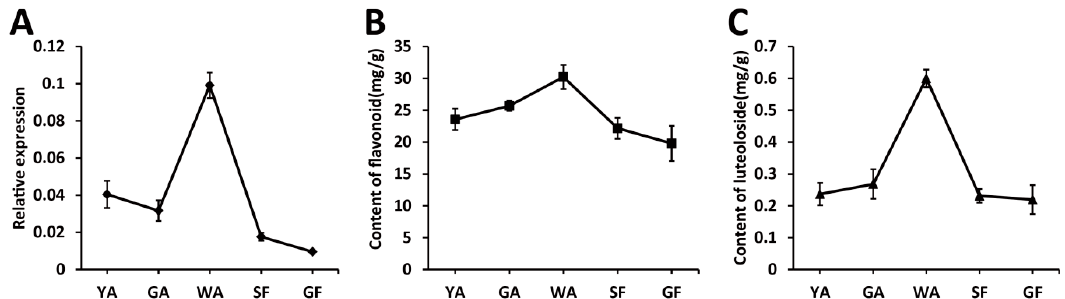
Figure 2. Transcriptional levels of LjaMYB12 and flavonoid contents in flower buds of L. japonica at different developmental stages. ( A ). Transcriptional patterns of LjaMYB12 . ( B ). Flavonoid contents. ( C ). Luteoloside contents. YA-young alabastrum, GA-green alabastrum, WA-white alabastrum, SF-silvery flower, and GF-golden flower.